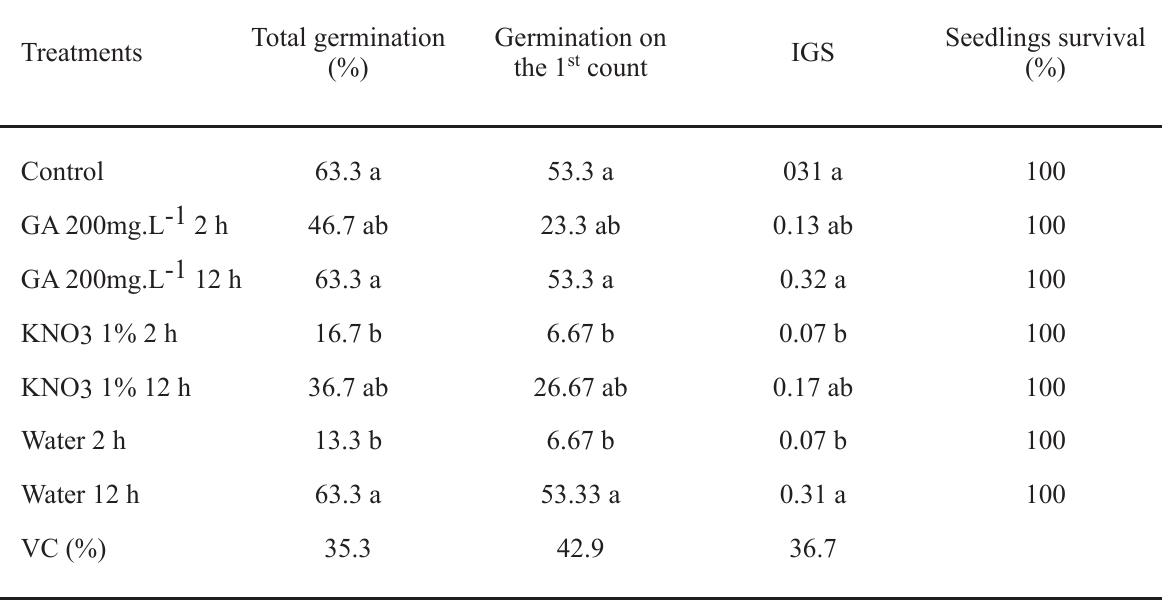
Means followed by the same small letter in the column are statistically equal by Tukey test at 5% of